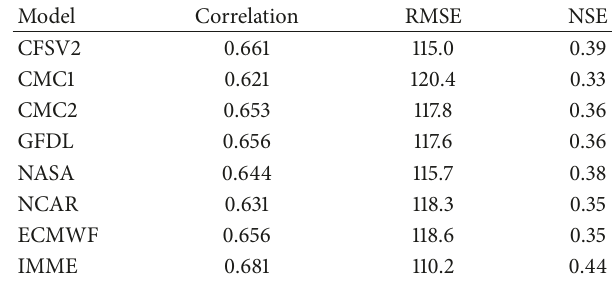
Table 4: Correlation, RMSE, and NSE for observed three months’ precipitation versus the models predictions: Northern Israel, Lati- tude: 33.0, Longitude: 35.0.